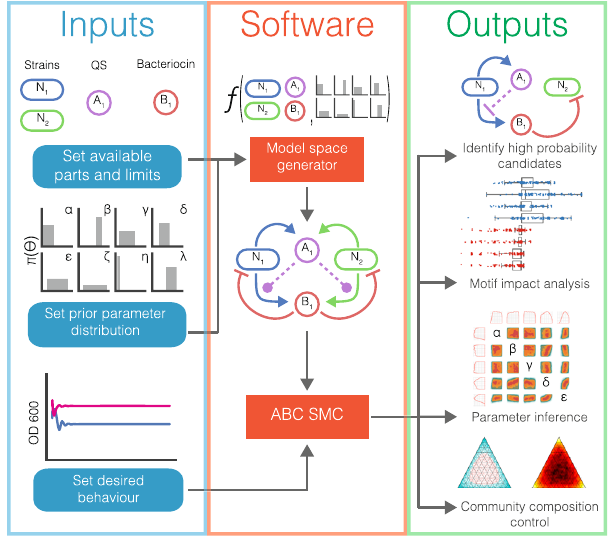
Fig. 1 Overview of AutoCD pipeline. Model selection work fl ow begins with de fi nition of available parts and prior parameter distributions used to generate system models from all the possible interactions. We use ABC SMC to perform model selection for the desired population behaviour. The outputs of ABC SMC provide us with community designs, insight into underlying motifs, parameter requirements and information on composition